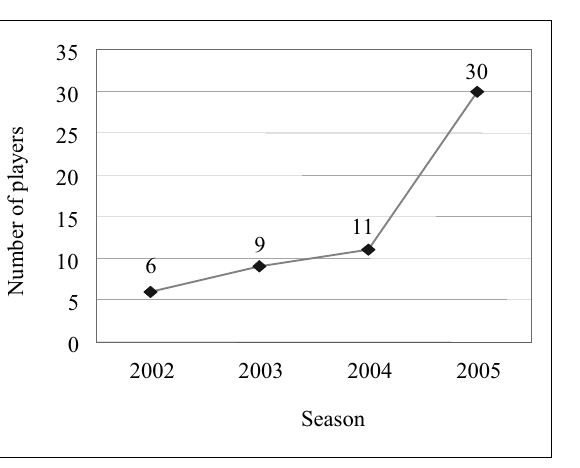
Fig. 2. The dynamics of the foreign players in the LFLA